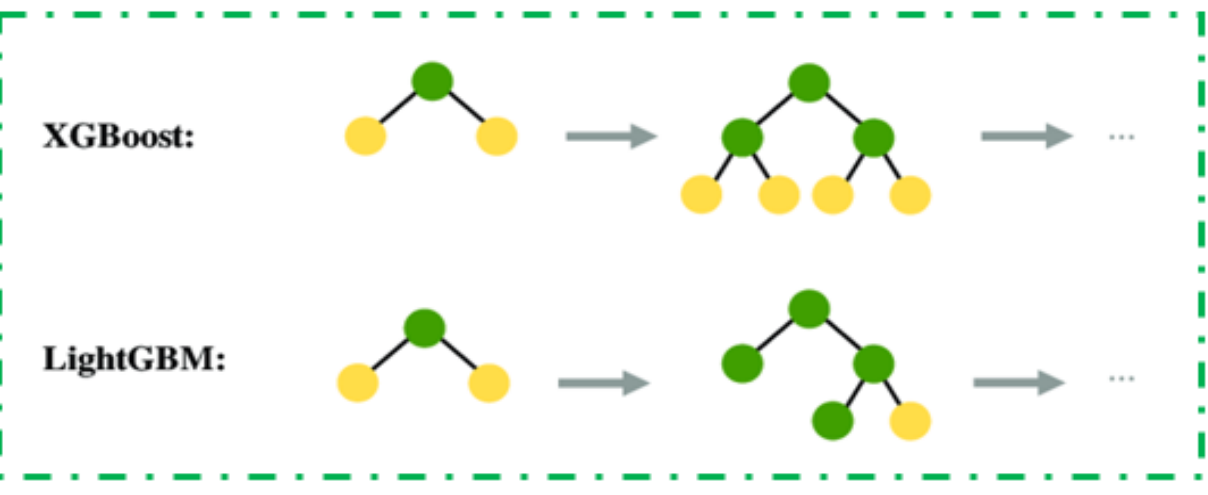
Figure 8. Random Forest Classifier Architecture. CatBoost is a technique for decision trees that uses gradient boosting. The model ex- cels at handling categorical variables. CatBoost can handle categorical data directly, with- out the requirement for preprocessing or encoding, in contrast to many other gradient- boosting tools. This makes it an easy tool to use when working with datasets that include a lot of categorical variables, like our dataset. In contrast to XGBoost and LightGBM, CatBoost constructs symmetric (balanced) trees. The same condition is used to separate the leaves in each phase from the preceding tree. For each node in the level, the feature-split pair that causes the least loss is chosen and applied. This balanced tree architecture facilitates effective CPU implementation, re- duces prediction time, produces quick model implementers, and inhibits overfitting due to the structure’s regularization. Figure 9 depicts the CATBoost symmetric tree.